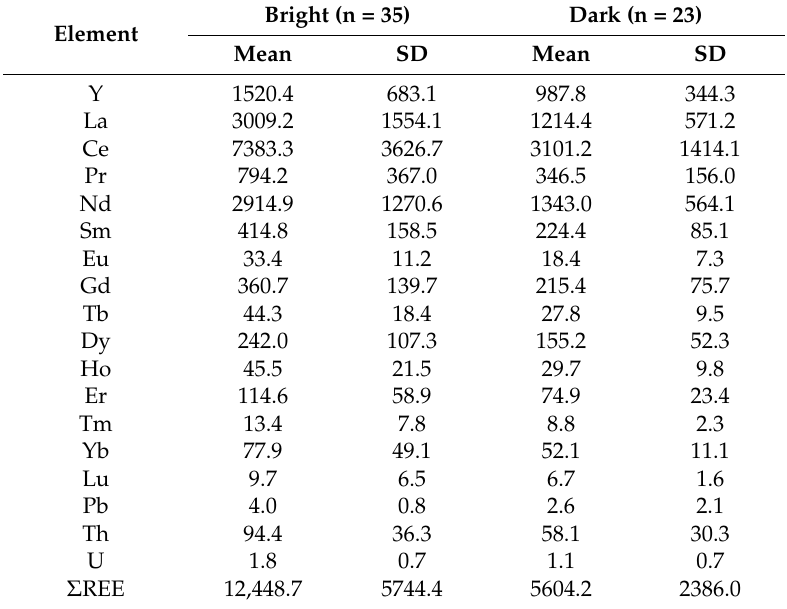
Table 5. LA-ICP-MS data (ppm) for bright and dark apatites from Chadormalu MAV-host rock apatite